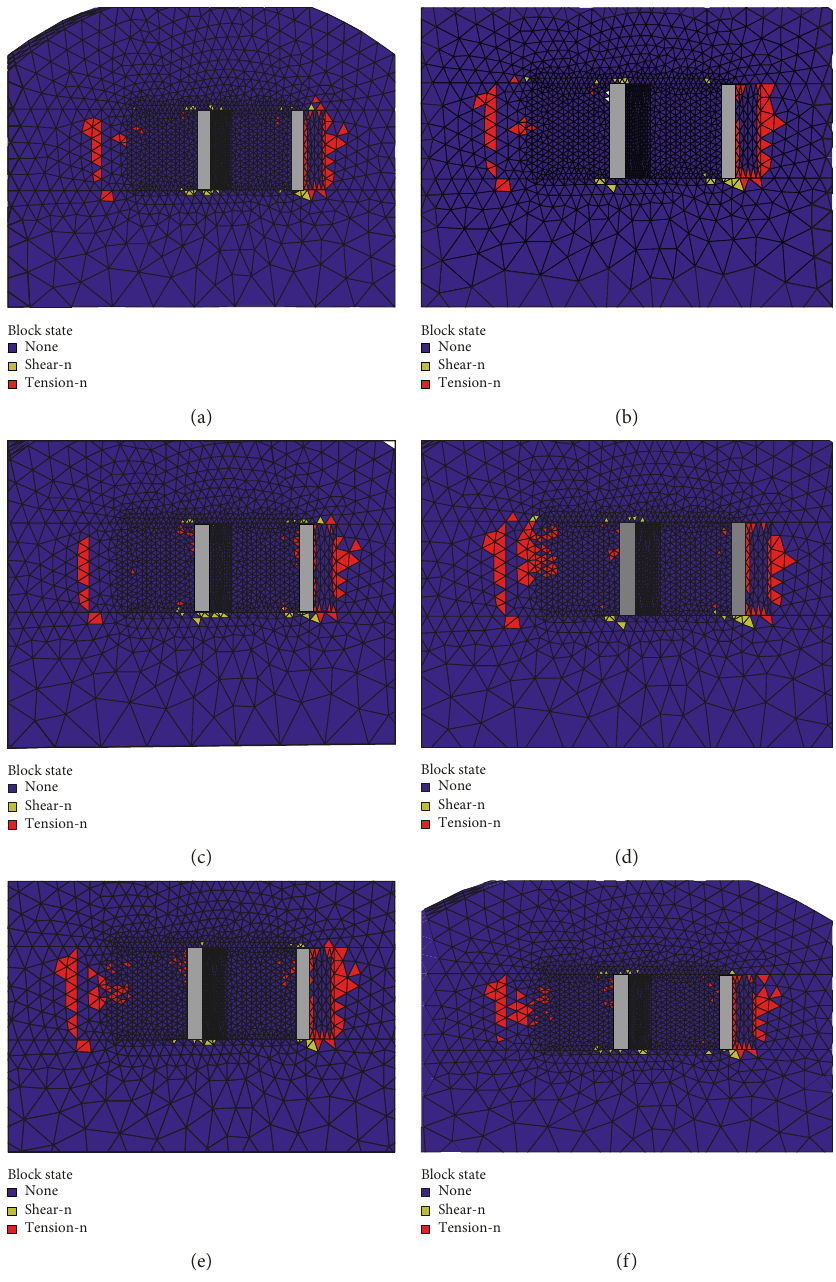
Figure 4: Plastic zone distribution map: (a) cement-sand ratio 1 :6, backfill concentration 68%; (b) cement-sand ratio 1:6, backfill concentration 72%; (c) cement-sand ratio 1 :6, backfill concentration 78%; (d) cement-sand ratio 1:8, backfill concentration 68%; (e) cement-sand ratio 1: 8, backfill concentration 72%; (f) cement-sand ratio 1 :8, backfill concentration